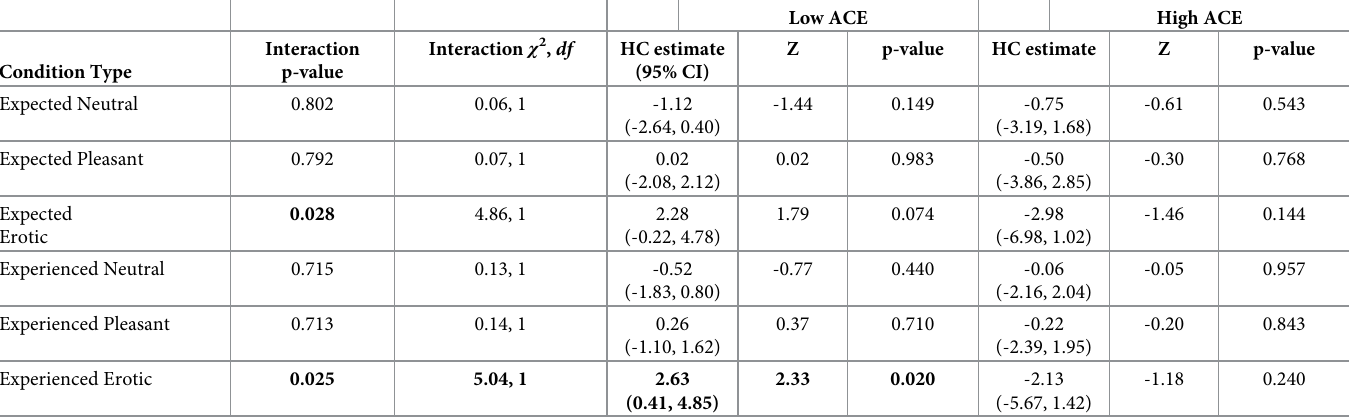
Table 2. Hormonal contraception (HC) use interacted with prepubertal adverse childhood experiences (ACEs) to predict expected and experienced valence of erotic images but not neutral or pleasant